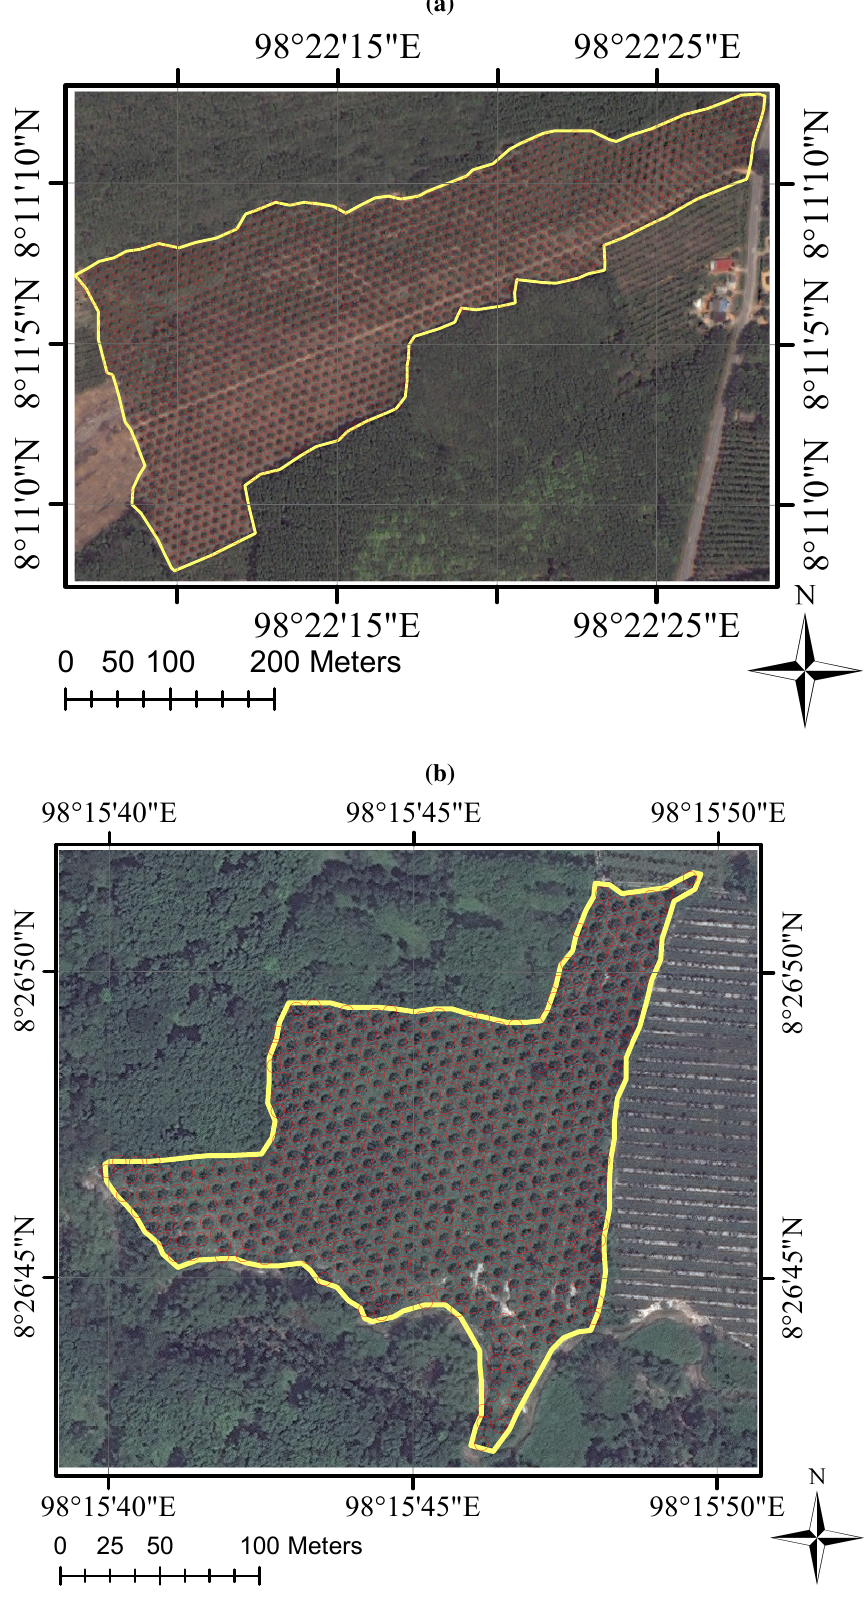
Figure 7. Two examples of detection results from QuickBird imagery are shown in ( a , b ). The detected oil palm trees from the proposed method are marked with red circles. Note that the diameter of red circles has no relationship with the diameter of tree